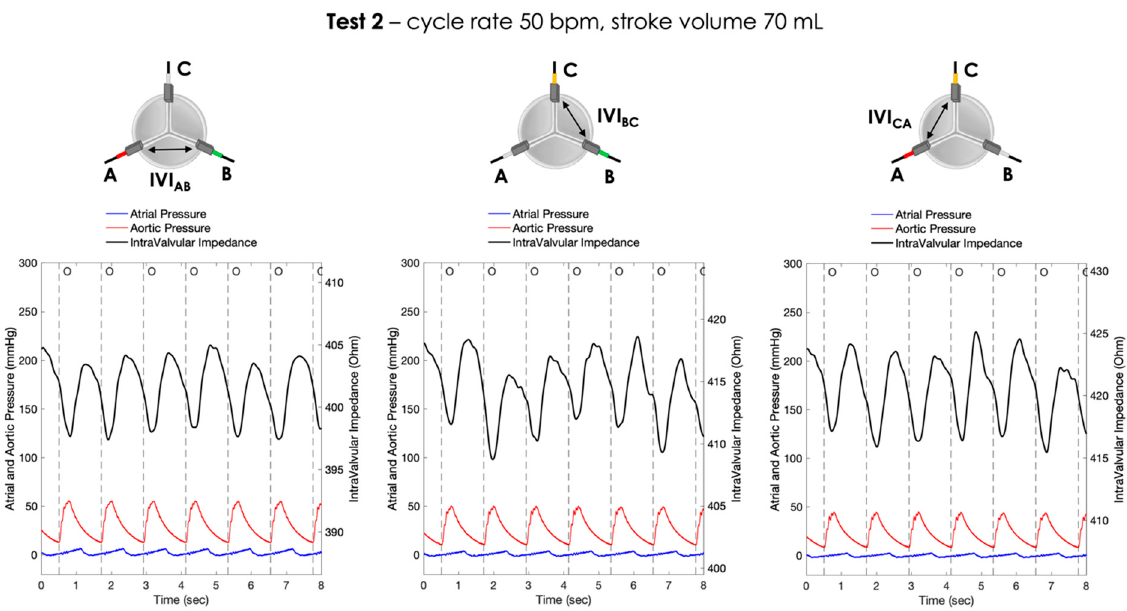
Figure 7. Atrial pressure, aortic pressure and IVI signal recorded inside the porcine heart in the three pairs of electrodes during Test 2 (cycle rate 50 bpm, stroke volume 70 mL): AB ( left ), BC ( center ) and CA ( right ). O = start of valve opening identified with the low peak of the aortic pressure.